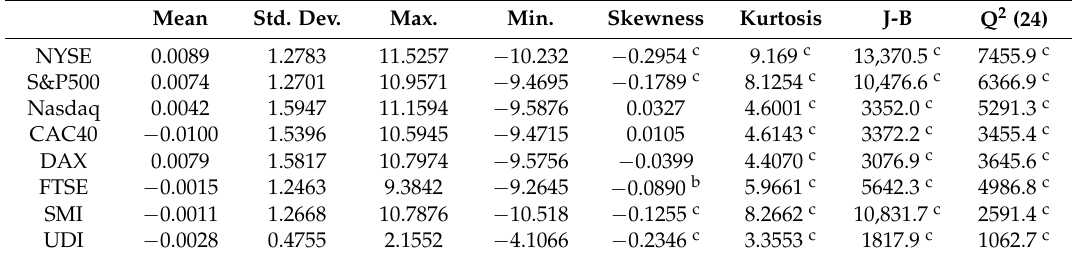
Table 1. The descriptive statistics of daily return for the overall